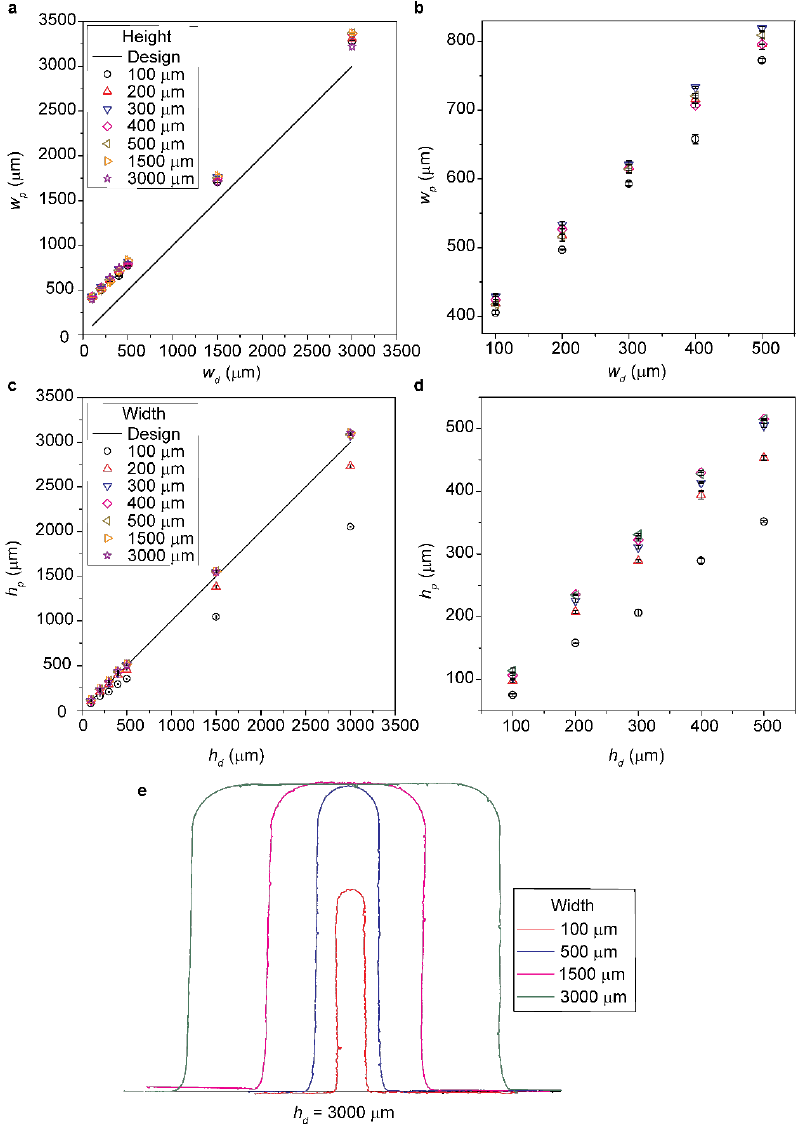
Figure 2. ( a , b ) Plot of wp against wd for h d = 100 – 3000 µm, and a magnified view for w d = 100 – 500 ( a , b ) Plot of wp against wd for h d = 100–3000 µ m, and a magnified view for µm. ( c , d ) Plot of hp against hd for w d = 100 – 3000 µm, and a magnified view for h d = 100 – 500 µm. w d = 100–500 µ m. ( c , d ) Plot of hp against hd for w d = 100–3000 µ m, and a magnified view for ( e ) Cross-sectional profile for h d = 3000 µm with varying wd, suggesting the decrease in the printed h d = 100–500 µ m. ( e ) Cross-sectional profile for h d = 3000 µ m with varying wd, suggesting the height for w d = 100 µm. decrease in the printed height for w d = 100 µ